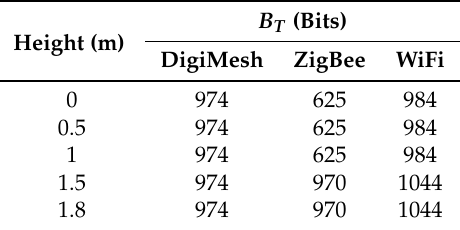
Table 7. Bit rate vs. height sensor